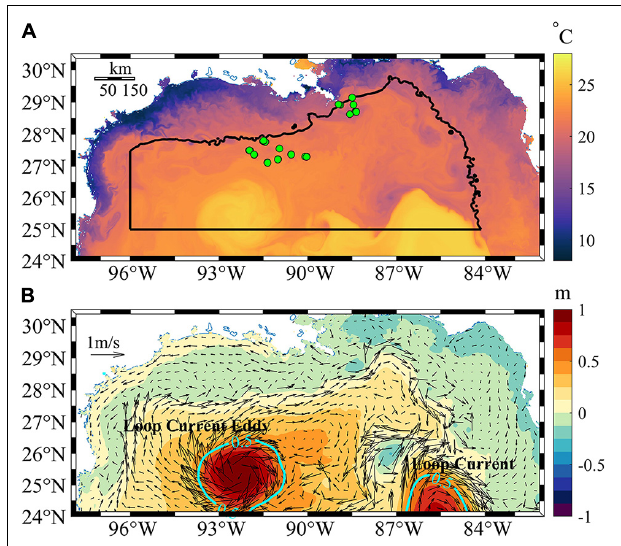
FIGURE 1 | (A) Instantaneous surface temperature of the Gulf of Mexico at 00:30 GMT February 4, 2015. The black curve highlights the region where passive Lagrangian particles are released. Green dots indicate sampling locations for a 2015 summer cruise used to evaluate the model’s performance (see Supplementary Figure 1 ). (B) Corresponding instantaneous modeled sea surface height (SSH) field with superimposed surface flow velocities. Contours indicate 0.5 m SSH isobaths. In all snapshots throughout the paper, the time is 00:30